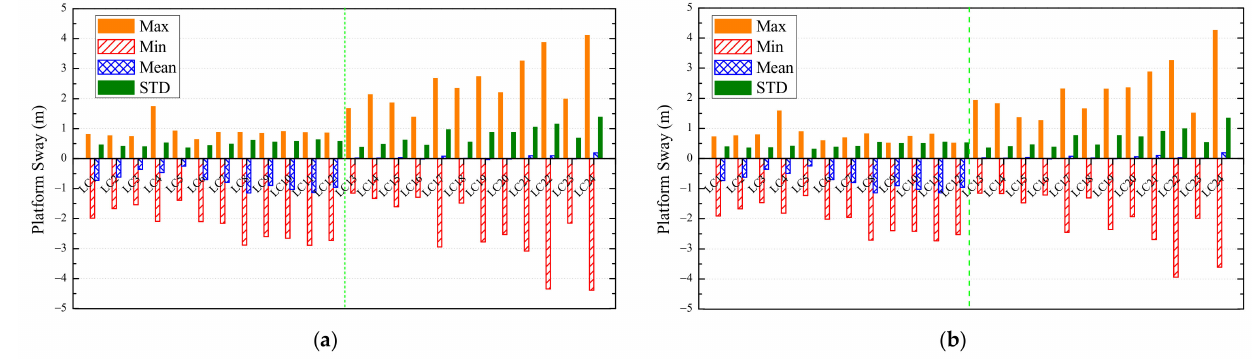
Figure 12. Statistics of platform sway motion response for ( a ) without current; ( b ) with current.